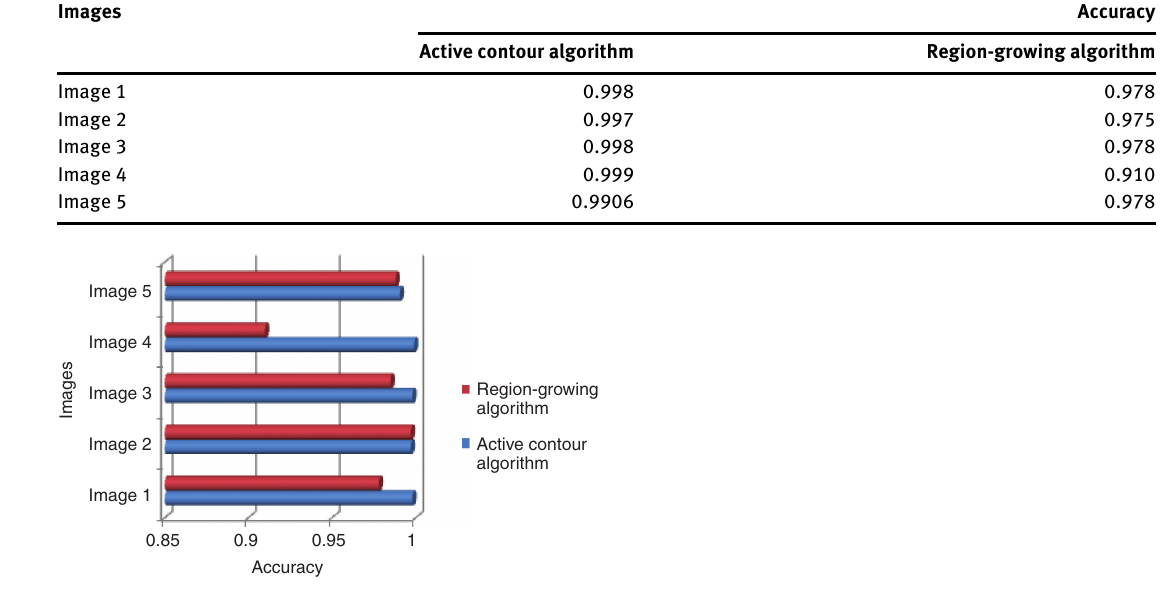
Figure 6: Accuracy Comparison of Proposed